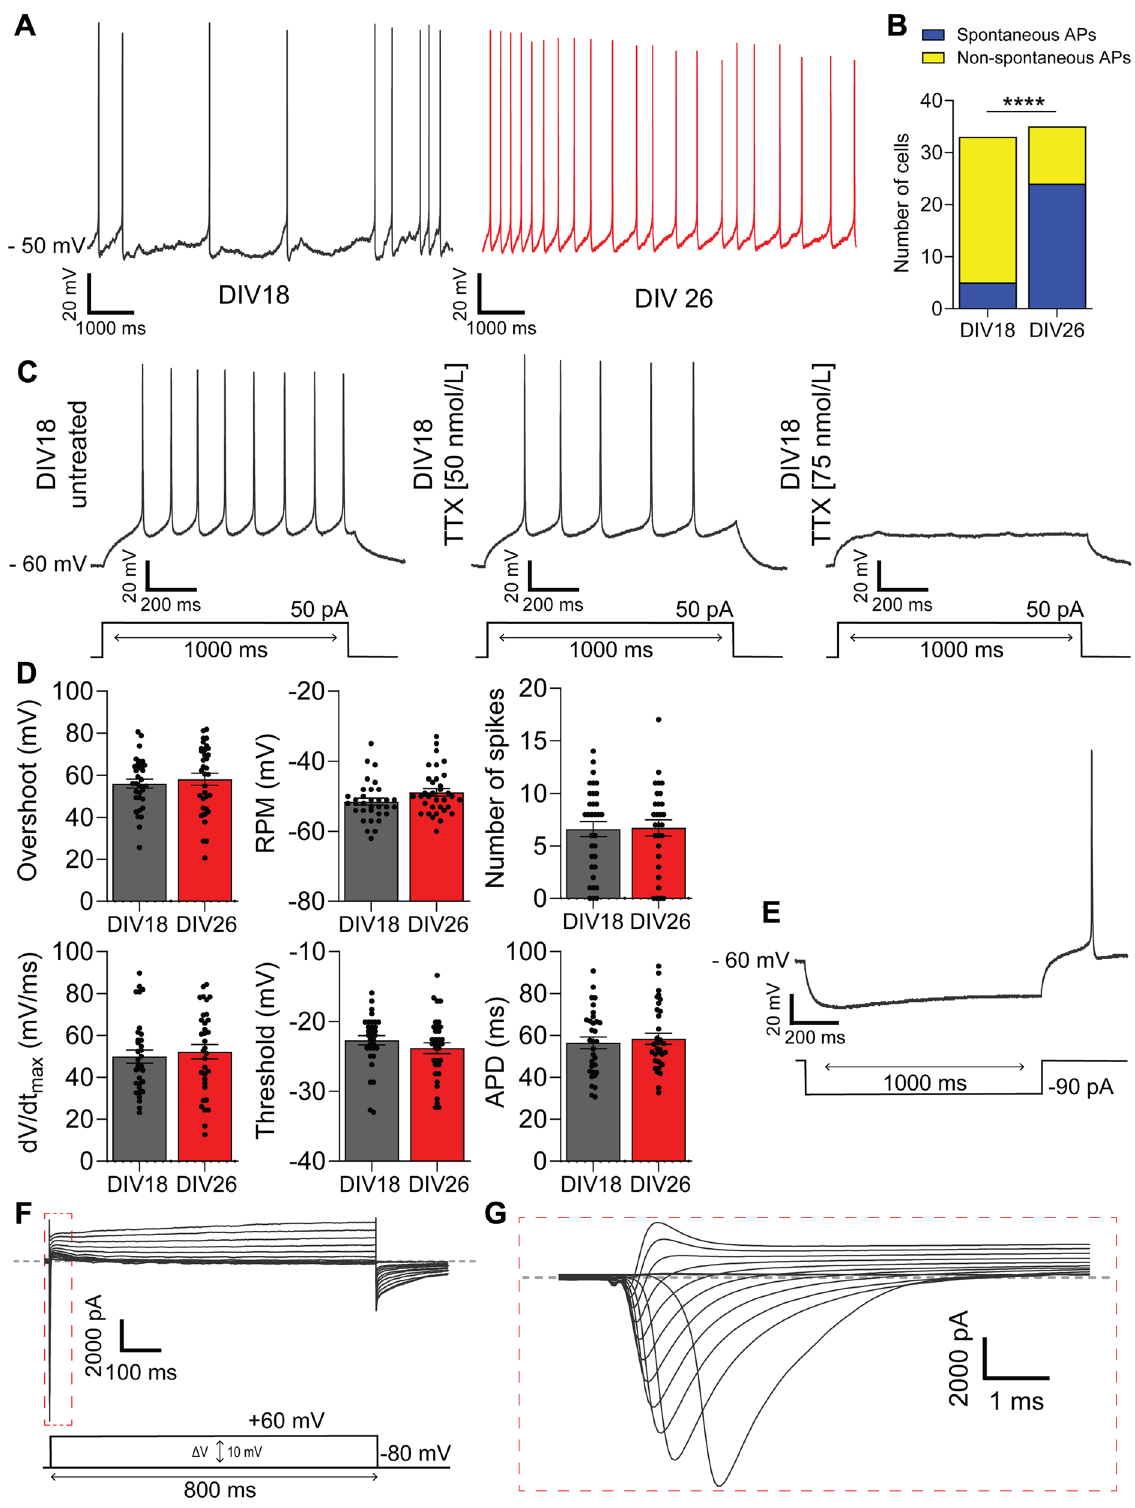
Figure 4. iDA neurons are electrically functional and mature at DIV 18. ( A ) Representative traces of the spontaneous action potentials (APs) recorded from DIV 18 (left, black) and the DIV 26 (right, red). ( B ) Stacked bar showing the cells number which fired spontaneous APs. Fisher’s exact test was used to assess significance within each group **** p < 0.0001. ( C ) Representative APs from DIV 18 in response to a 50 pA depolarizing current injection (bottom) before and after TTX treatment (50 and 75 nmol/L). ( D ) Bar graph showing the mean ± SEM of the resting potential membrane (RPM), the spikes frequency or number, the threshold, the overshoot, the dV/dtmax and the AP duration APD) from DIV 18 (n = 33 cells from n = 3 independent experiments) and DIV 26 (n = 34 cells from n = 3 independent experiments). A two-tailed unpaired Student’s t-test was used to assess differences between groups. ( E ) Representative AP from DIV 18 in response to a − 90 pA hyperpolarizing current injection. ( F ) Phase contrast image of a patched cell. Scale bar: 20 µm. ( G ) Representative voltage-activated Na + and K + currents elicited using 800 ms pulses from − 100 to + 60 mV in + 5 mV. The dashed line represents zero current. ( H ) Close-up view of voltage-activated Na +